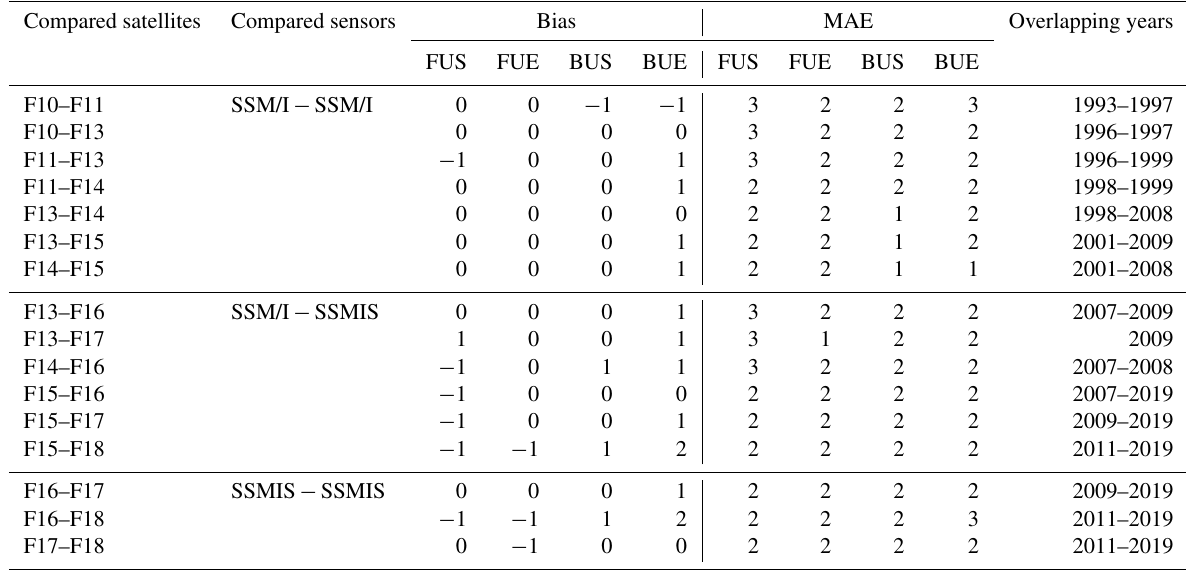
Table 3. Comparisons of lake ice phenology results from different satellites. FUS, FUE, BUS, and BUE represent freeze-up start, freeze-up end, breakup start, and breakup end date, respectively.